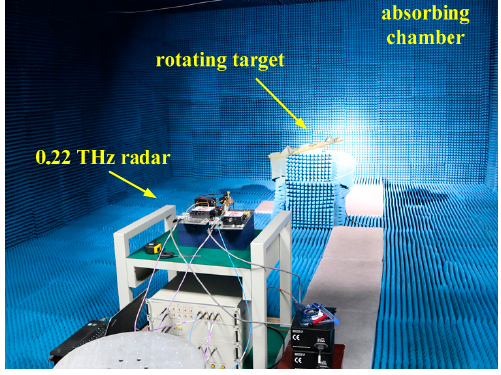
Figure 4. The experimental scenario. Sensors 2017 , 17 , 993